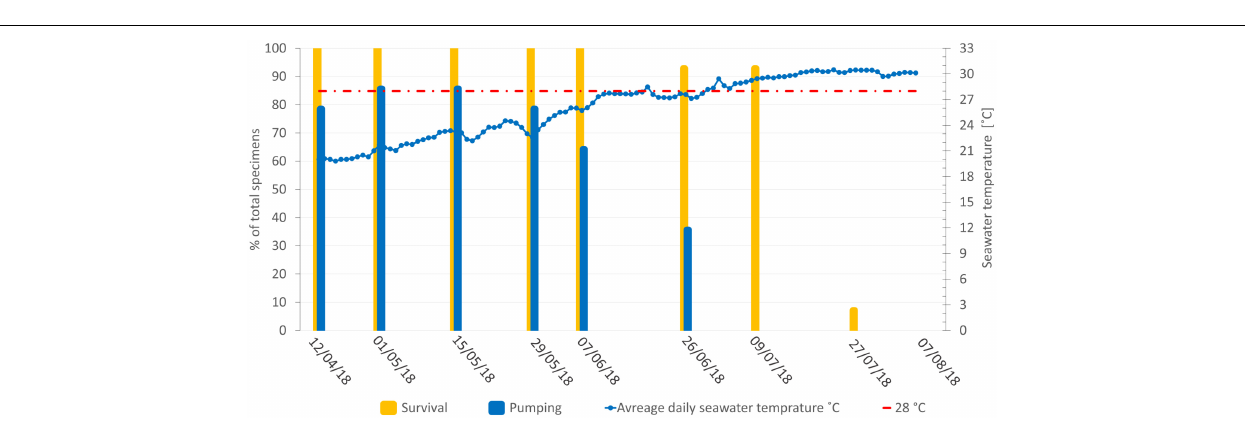
FIGURE 6 | Survival of Agelas oroides specimens (%) and water temperature ( ◦ C) at the shallow transplantation site. The percentage of survival was calculated as the number of live sponges (not necessarily pumping water) out of the total number of sponges; The percentage of pumping specimens was calculated